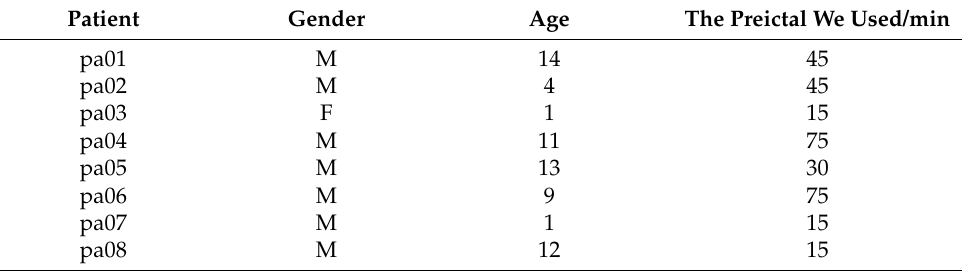
Table 2. Illustrations of the ZJU4H dataset we